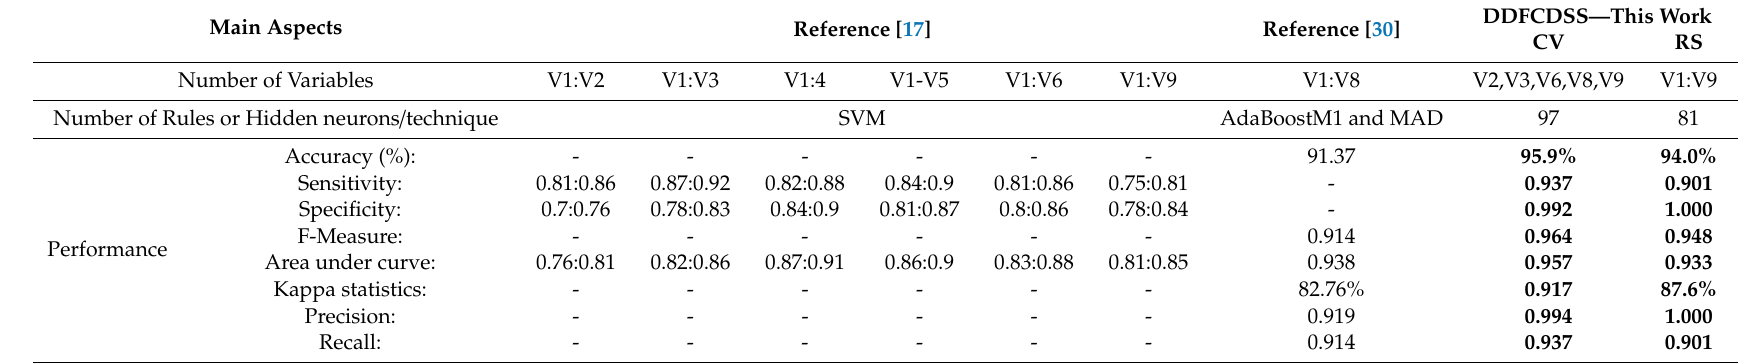
Table 10. Performance metrics obtained with our proposed framework and other classifiers obtained from the literature for